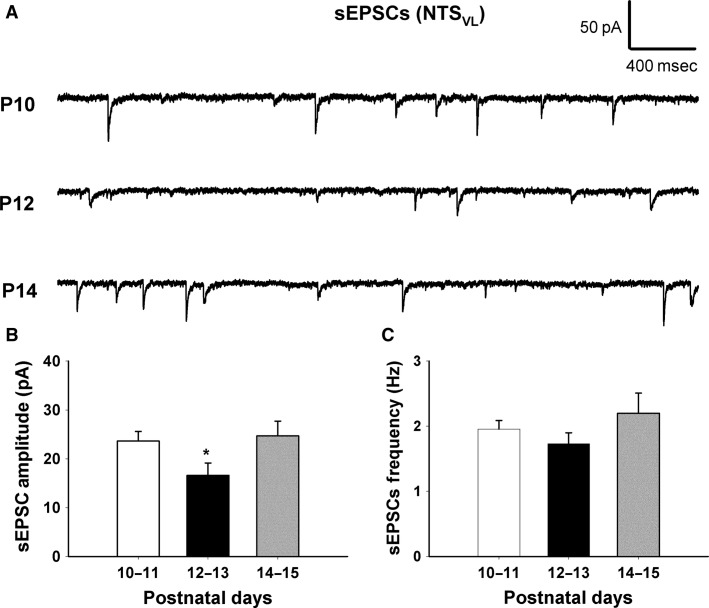
The amplitude of sEPSCs in normal NTSVL neurons decreased during the critical period (P12-13). (A) Sample traces of sEPSCs recorded at different postnatal days (P10, P12 and P14). (B) Mean amplitude (in pA) of sEPSCs is shown at three time points (P10-11, P12-13, and P14-15). It exhibited a significant decrease at P12-13 (P < 0.05). (C) Mean frequency (in Hz) of sEPSCs is displayed at three time point (P10-11, P12-13 and P14–15). Data are presented as mean ± SEM, *P < 0.05 (significance between adjacent age groups).